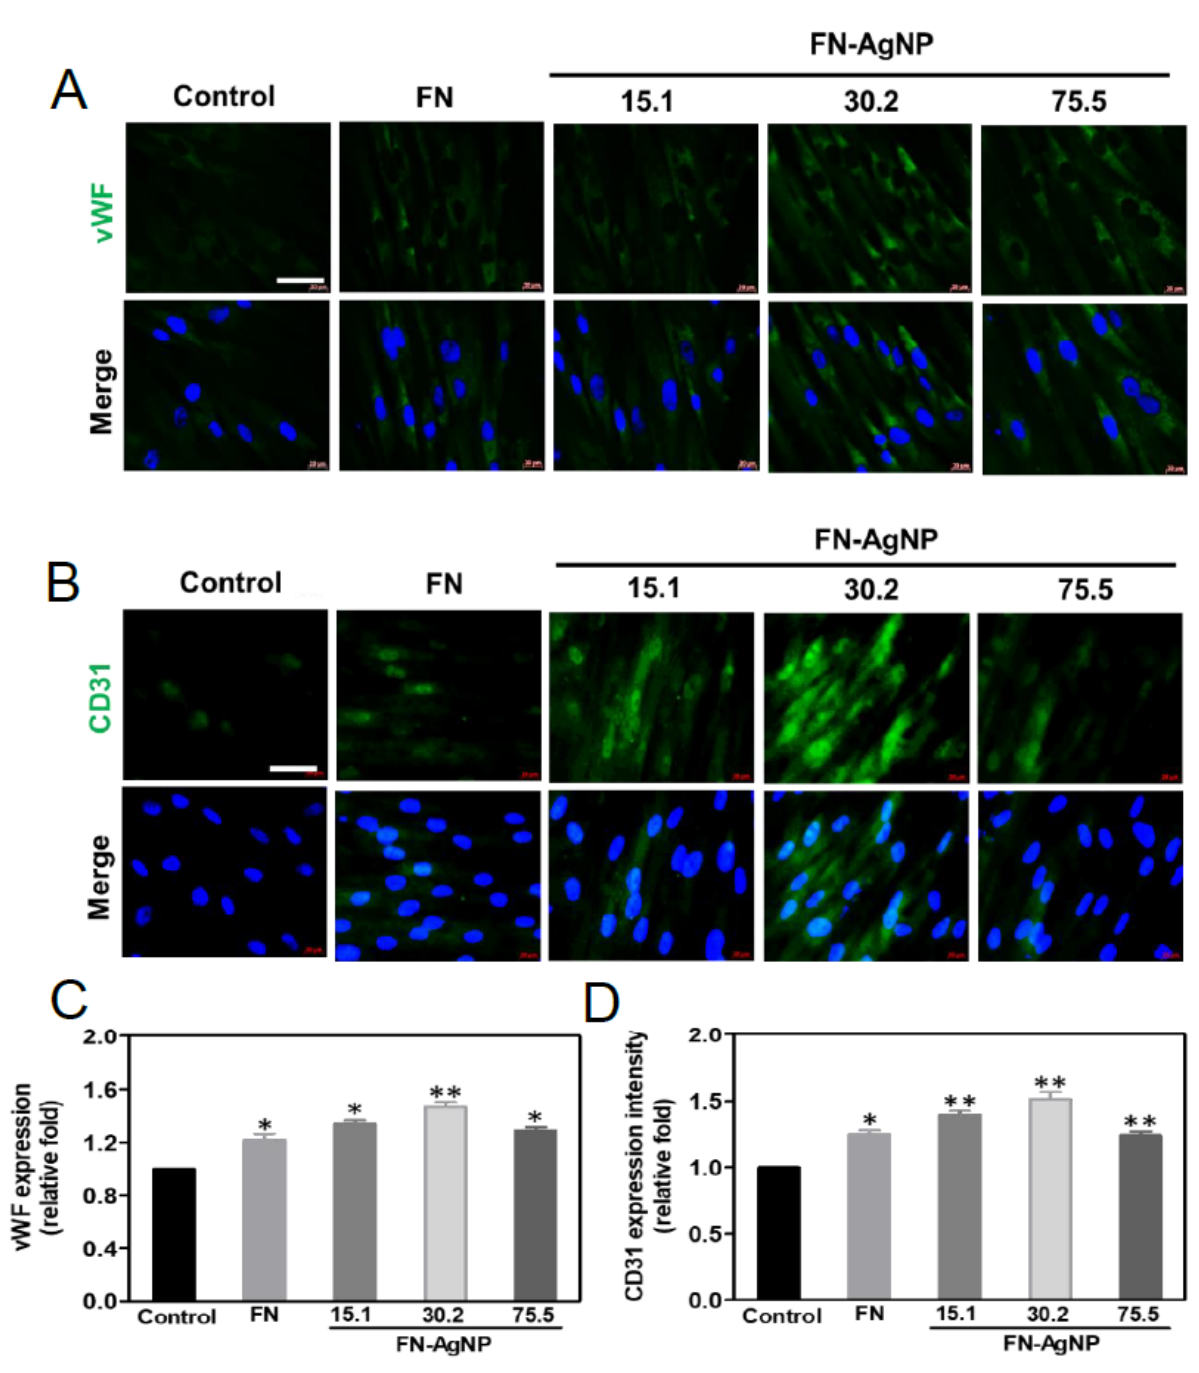
Figure 5. Differential expression of CD31 and vWF protein in MSCs culturing with various nanomaterials at day seven. The MSCs were firstly stained by primary ( A ) anti-CD31 and ( B ) anti-vWF antibody and conjugated with FITC secondary antibody (green color). The cell nucleus was located by DAPI (blue color). The images were taken by fluorescence micros- copy. Scale bar = 20 µ m. ( C , D ) The quantitative results of fluorescence intensity for CD31 and vWF revealed a higher expression amount in FN-AgNP 30.2 ppm group. Data are the mean ± SD ( n = 3). * p < 0.05; ** p < 0.01: greater than the control. Control group =